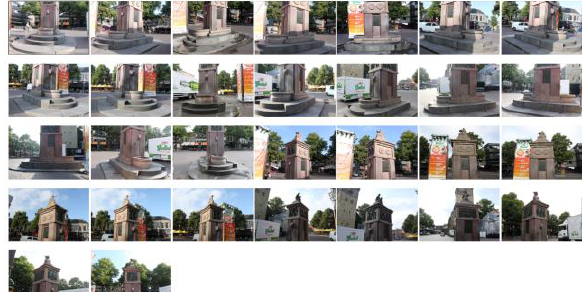
Figure 6. The dataset of 30 images of a monument (Alsadik et al., 2013).